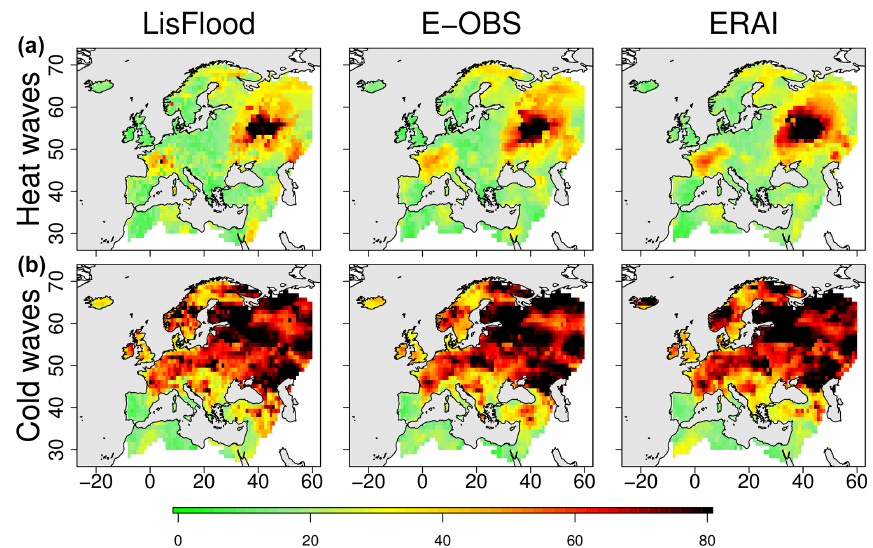
Figure 9. Spatial distribution of the strongest heat (a) and cold (b) waves intensities, defined as temperature anomalies (I2), using LisFlood, E-OBS and ERAI datasets.